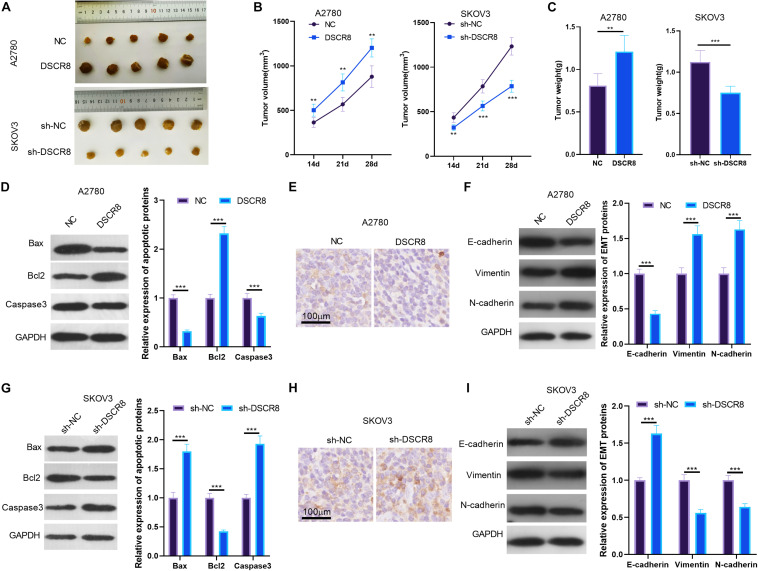
DSCR8 promoted tumor growth and epithelial–mesenchymal transition (EMT) in vivo. A2780 with overexpressed DSCR8 and SKOV-3 with knocked down DSCR8 were injected into nude mice. Four weeks later, tumor tissues from nude mice were isolated. (A) Tumor images of each group. (B) Tumor volume of each group. **P < 0.01, ***P < 0.001 vs. NC or sh-NC group, respectively. (C) Tumor weight of each group. (D,G). Western blot was used to measure the apoptosis (Bax, Bcl2, and Caspase3) in the formed tissues. (E,F,H,I). Immunohistochemistry and western blot were used to detect EMT-related proteins (E-cadherin, Vimentin, and N-cadherin) levels in tumor tissues. ***P < 0.001.